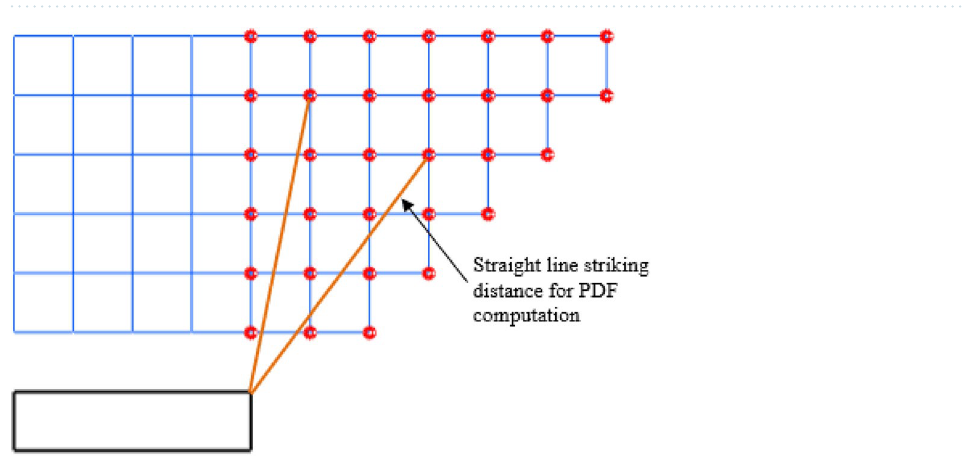
Figure 5. PDF-based pointwise computation of strike